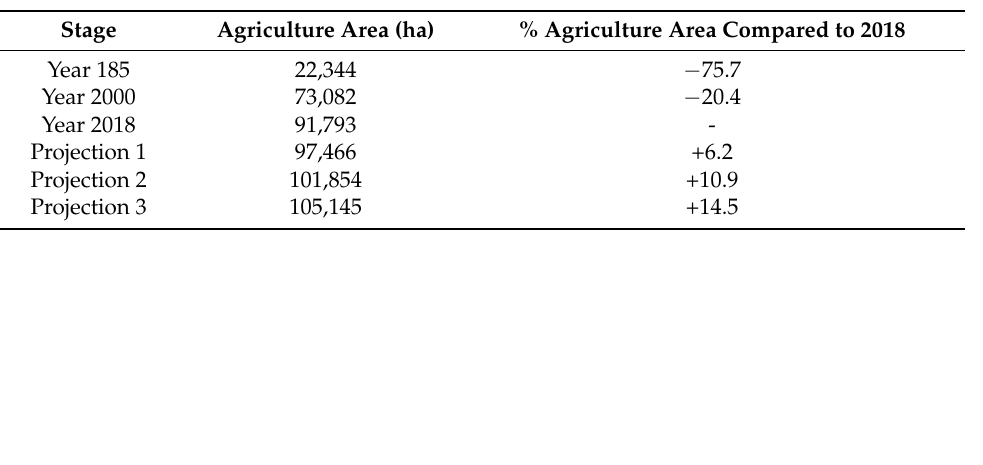
Table A5. Agriculture area for the different projections of agriculture